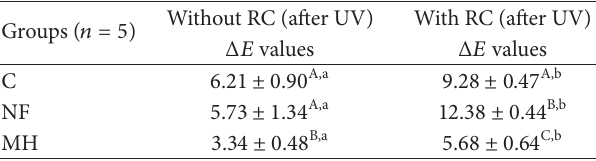
Table 5: Δ𝐸 values of the groups (mean ±